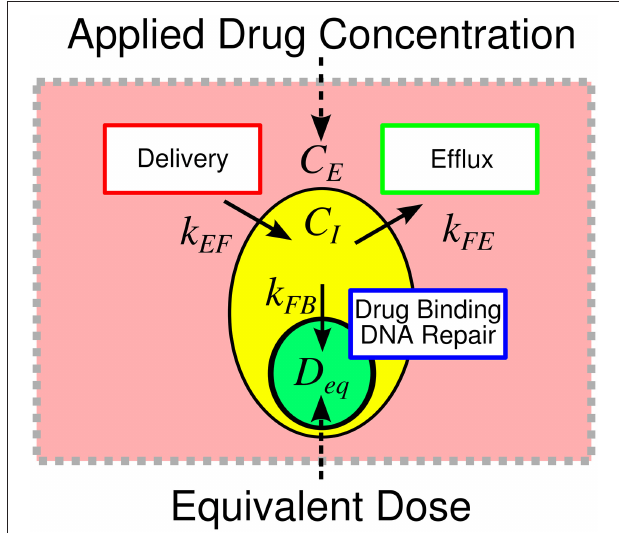
FIGURE 1 | Overview of equivalent dose metric. The response to therapy is determined by the applied drug concentration and cell-specific pharmacologic properties. Traditionally, therapeutic response is summarized relative to the applied extracellular concentration of drug. We propose the equivalent dose metric, D eq , to summarize the contributions of various pharmacologic properties in shaping treatment response. We define equivalent dose as a measure of the functional drug concentration that enters the cell. The equivalent dose is calculated through a mechanistic biophysical model that considers several sources of variability in shaping treatment response. The metric consolidates variable drug uptake (quantified with k EF ), efflux (quantified with k FE ), and binding (quantified with k FB ) into a single descriptor of treatment. The equivalent dose summarizes pharmacologic properties to provide biological insight into treatment response and allows for more precise comparison of treatment response among cell